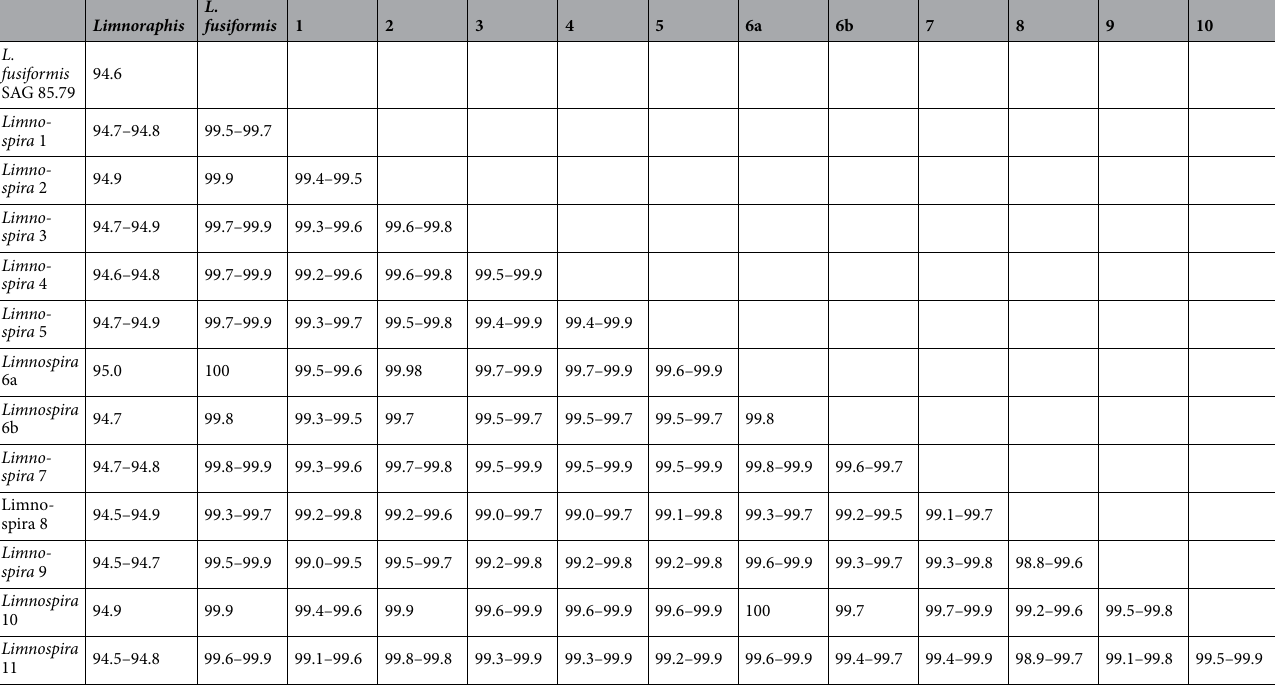
Table 2. Comparison of percentage of the 16S rRNA gene sequence identity among obtained Limnospira sequences, the reference strain of the type species L. fusiformis SAG 85.79 (CP051185), and an outgroup taxon Limnoraphis hieronymusii (AB045906). Numbers at Limnospira names correspond to numbers at Table 1. For Limnospira 1, 3, 4, 5, 7, 8, 9, and 11 sequences of 3 clones of the 16S rRNA gene were